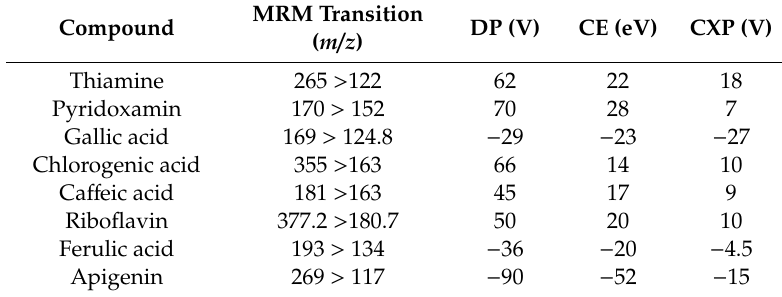
Table 1. Multiple-reaction monitoring (MRM) transitions, declustering potential (DP), collision energy (CE) and collision cell exit potential (CXP) of eight signature compounds. MRM Transition Compound